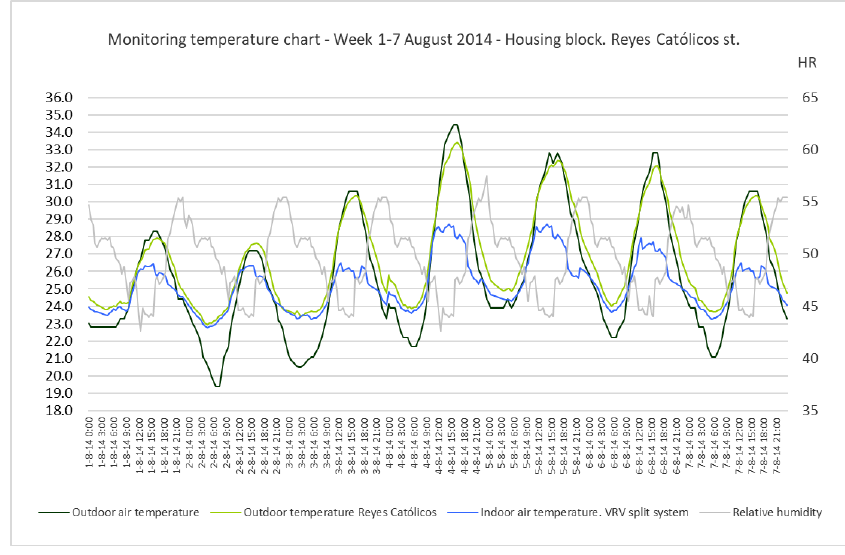
Figure 11. Loft flat. Q R _1. Temperature data obtained by monitoring, 1–7 August 2014.